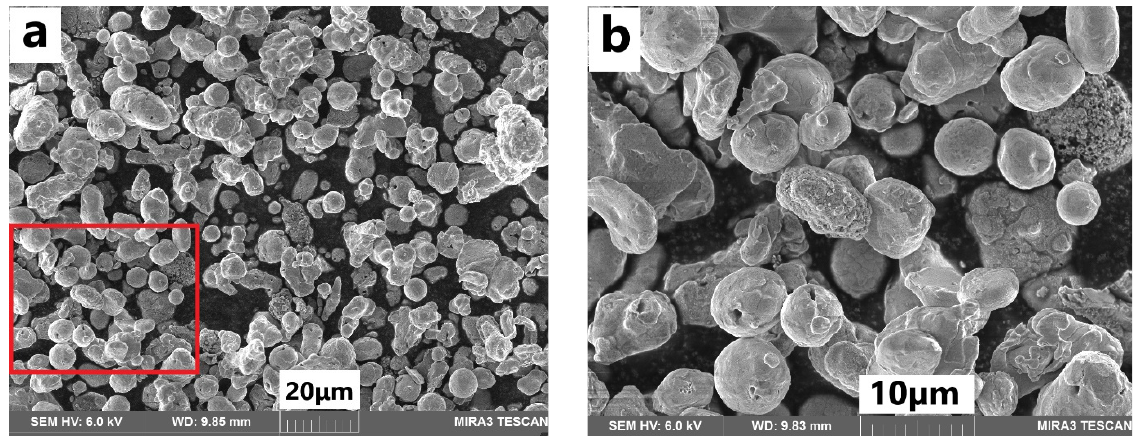
Figure 5. SEM image of the Cu particles in the as-received condition: ( a ) general image; ( b ) magnified image of the red square in ( a ).